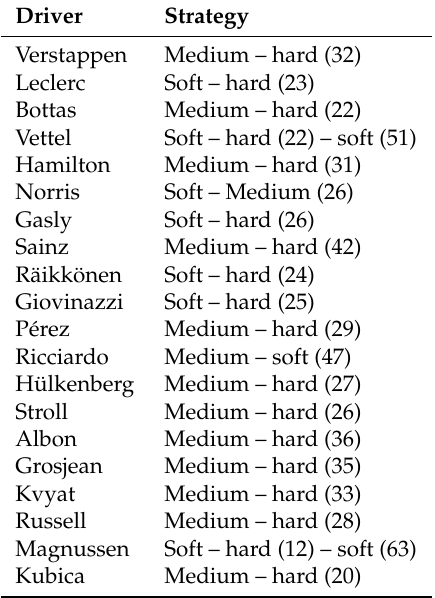
Table A2. Race strategies applied in the 2019 Austrian Grand Prix. The first lap with a new compound is stated in brackets. The real compound names are C2 (hard), C3 (medium), and C4 (soft). The drivers are listed in order of result